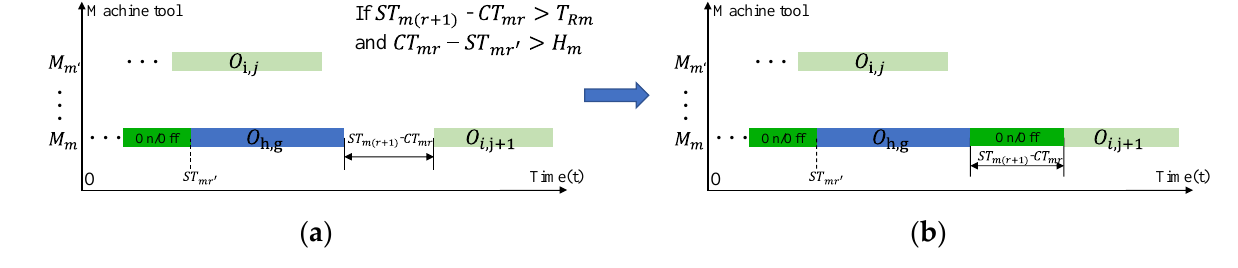
Figure 7. Scenario 1: ( a ) Initial Gantt chart; ( b ) Adjusted Gantt chart.